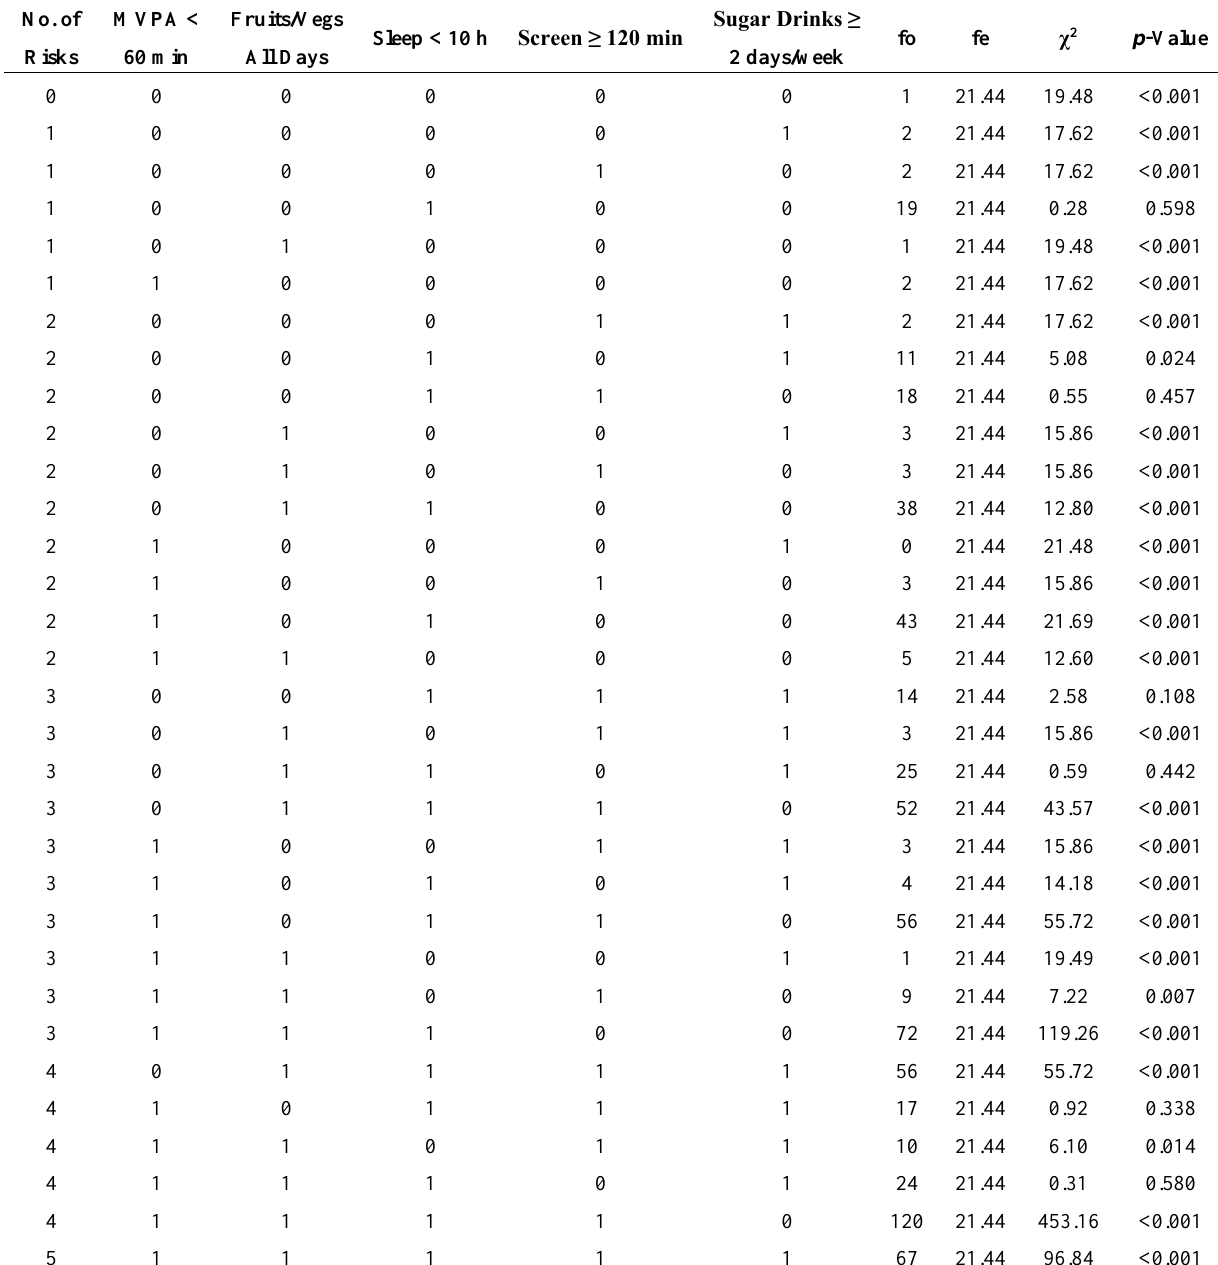
Table 2. Configurations of behavioural risks, their observed (fo) and expected frequencies (fe), χ 2 statistic and p